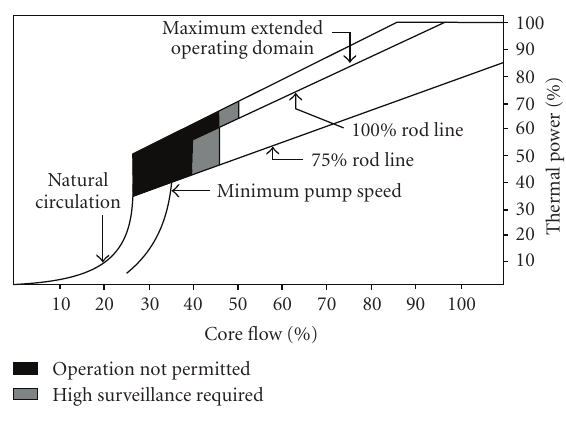
Figure 8: Typical BWR power-flow map.